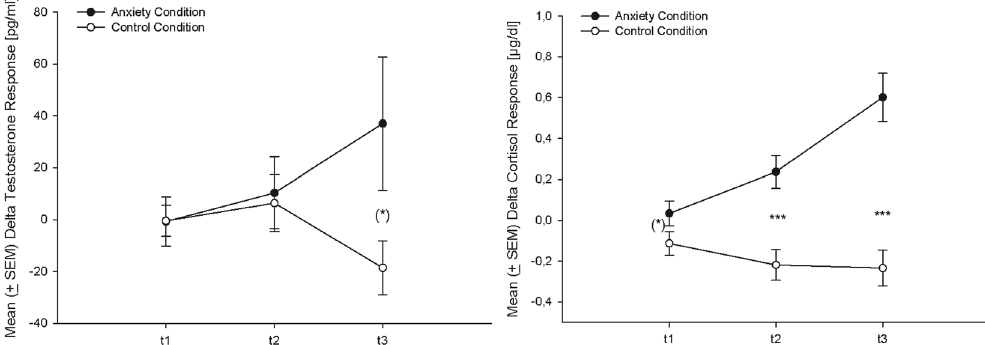
Figure 1. Testosterone (left, n = 17) and cortisol (right, n = 18) change-scores (in reference to baseline: Mean ± SEM) at the three time points (t1 = 30 minutes prior to the oral examination/ following the first bicycling set, t2 = immediately before the oral examination/ following the third bicycling set, t3 = immediately after the oral examination/ by the end of the ergometer session, time points separated by 30 min each), ( * ) p < 0.10, *** p < 0.001 (according to